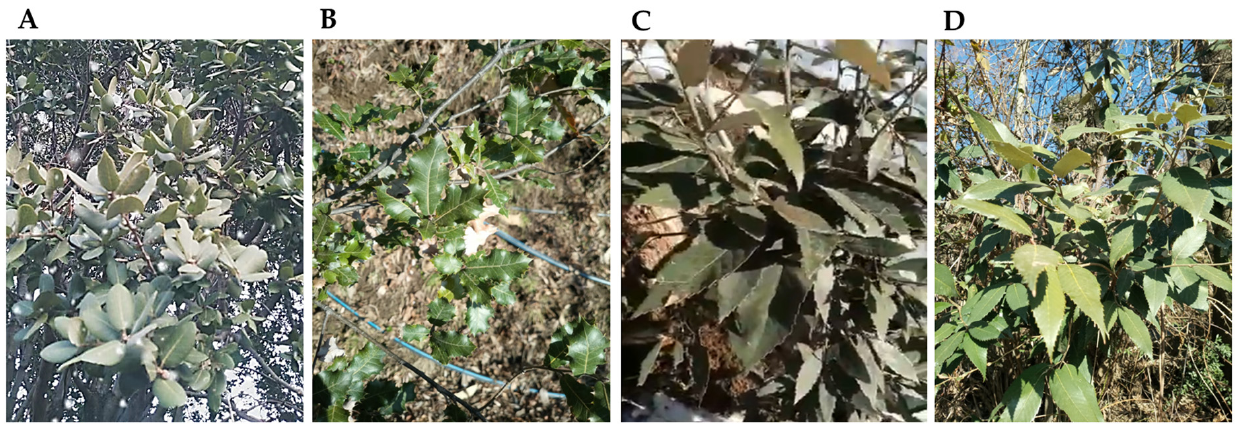
Figure 1. Representation of leaves of some oak species in Pakistan: ( A ) Q. baloot Griff., ( B ) Q. dilatata Royle., ( C ) Q. glauca Thunb., and ( D ) Q. incana Roxb. The photos were provided by Muhammad Khalil Ullah Khan.